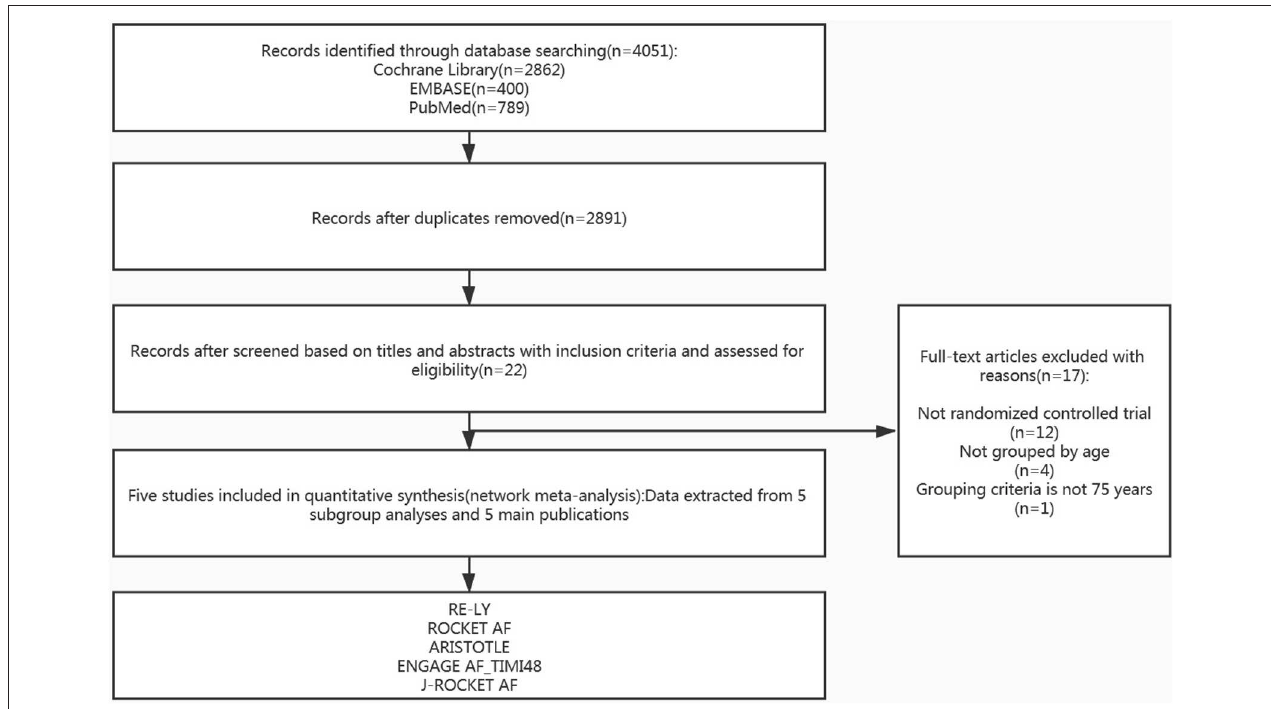
FIGURE 1 | Study flow diagram of the literature search and selection process of the included studies.